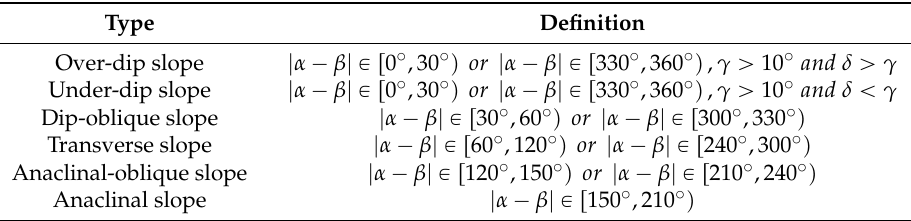
Table 3. Classification of the bedding structure.